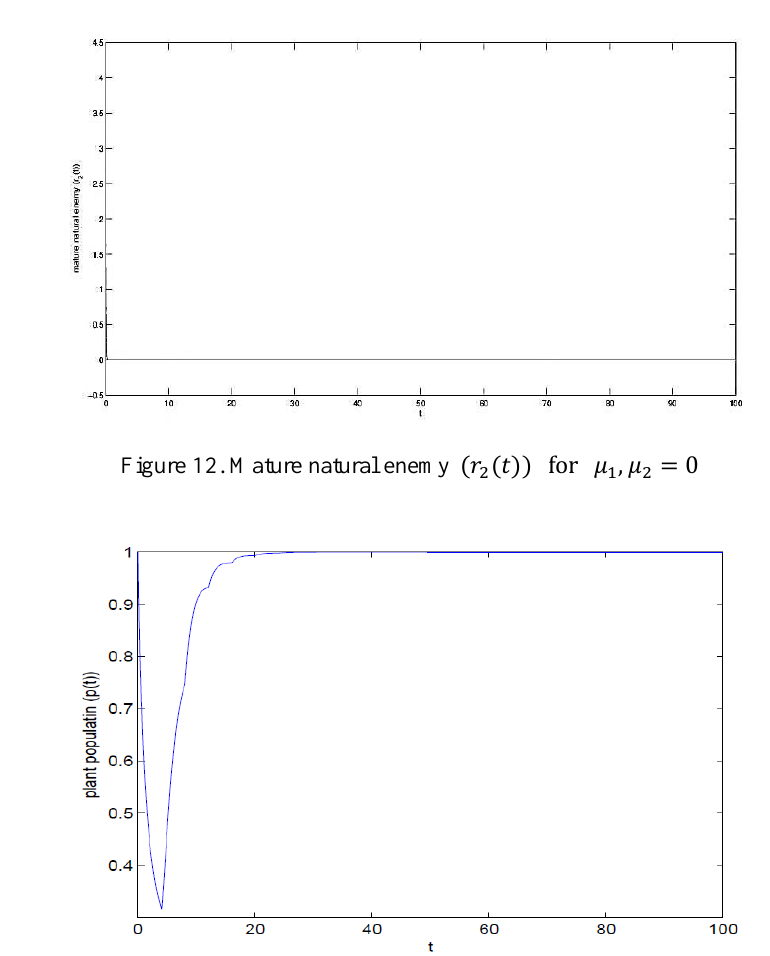
(𝑡)) vanishes for 𝜇 1